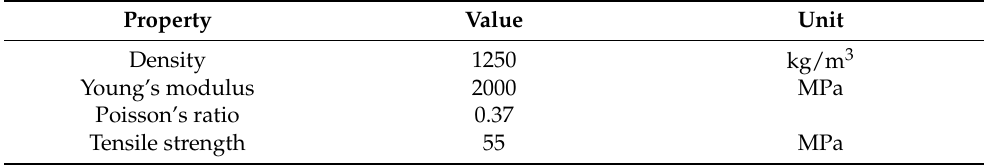
Table 2. The performance comparison of devices with different disc-cap radii of check-valves. Type of Wings with